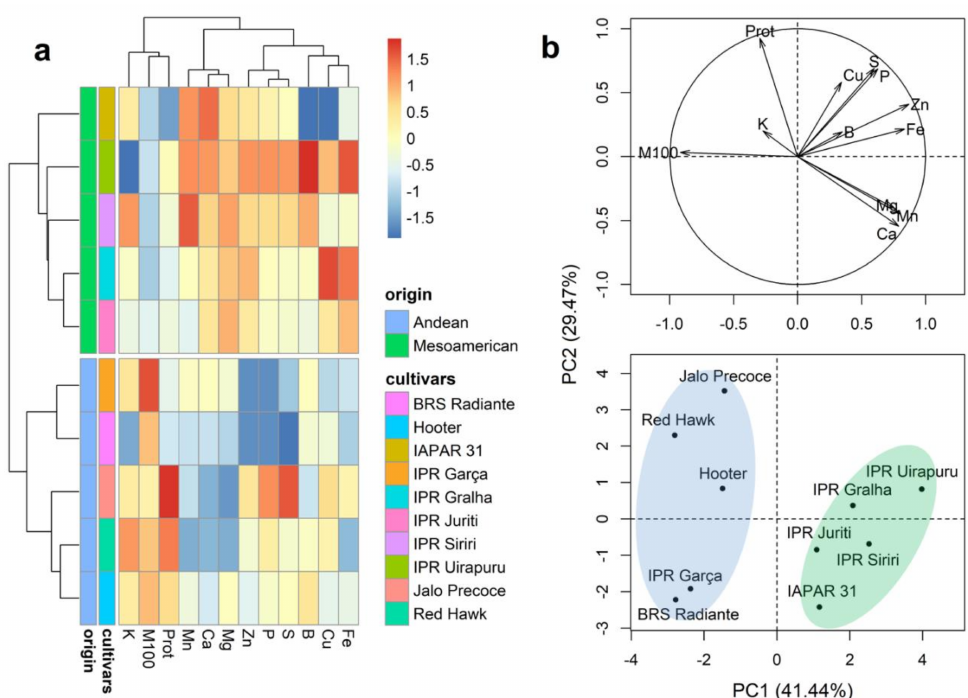
Figure 2. Dendrogram obtained based on Ward’s method ( a ) and principal component analysis ( b ) of 10 bean ( Phaseolus vulgaris L.) cultivars evaluated for the characteristics 100-grain mass (M100), protein content (Prot), and the contents of 10 minerals in whole